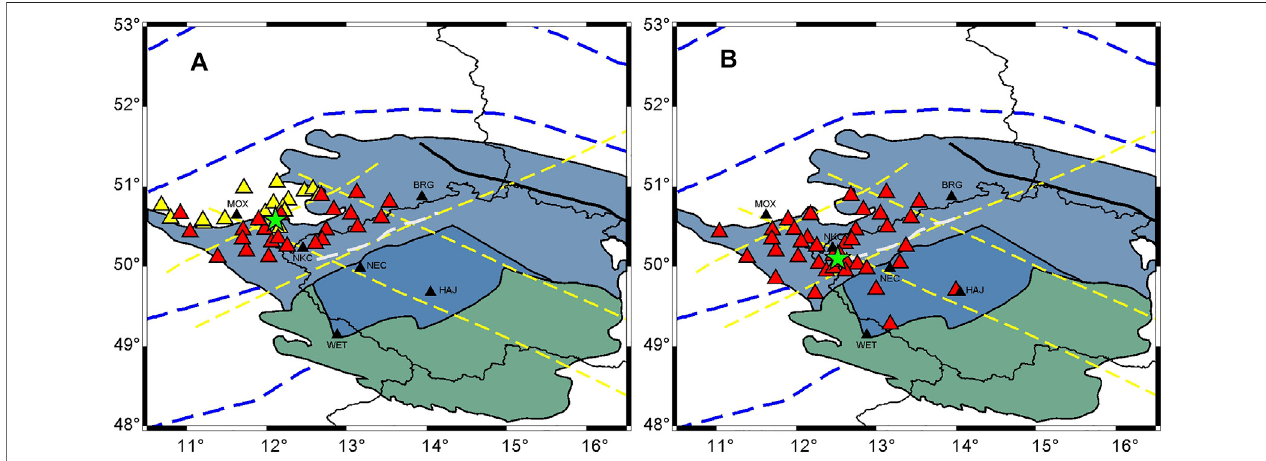
FIGURE8|(A) Distributionofstationsinsubarray1(yellowandredtriangles). (B) Distributionofstationsinsubarray2(redtriangles).Thetwogreenpentagramsare the centers of the two subarrays; see Figure 1 for explanations of the other symbols.